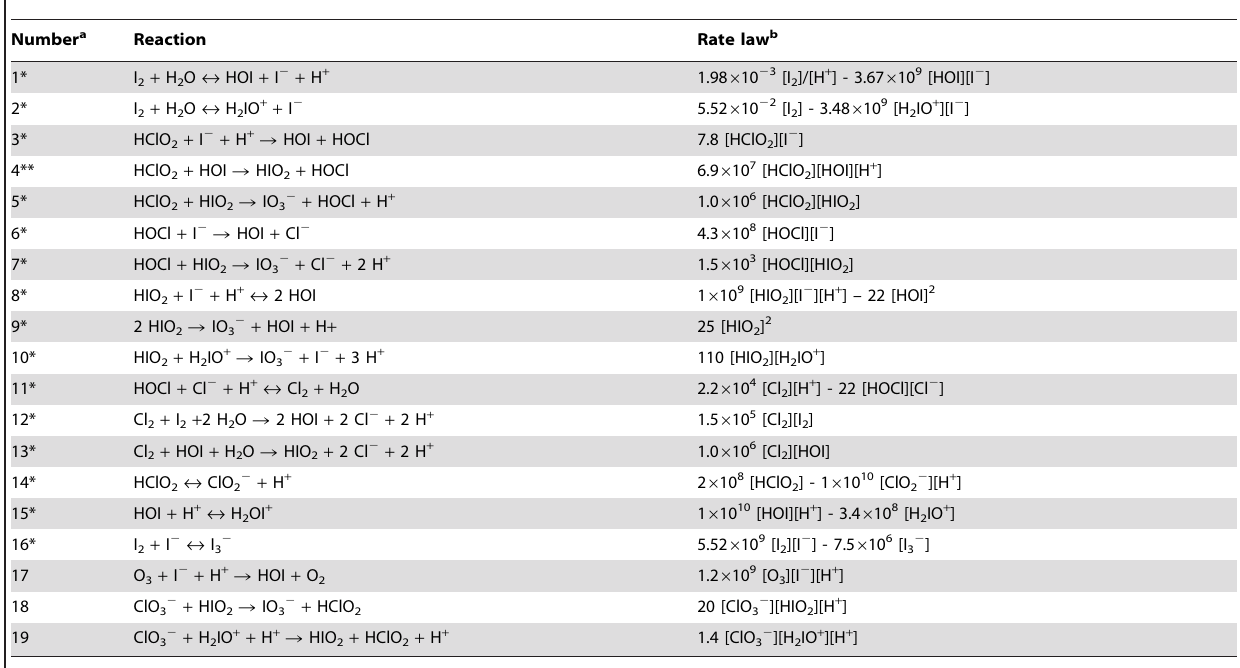
Table 1. Mechanism for the ozone-iodine-chlorate clock reaction.